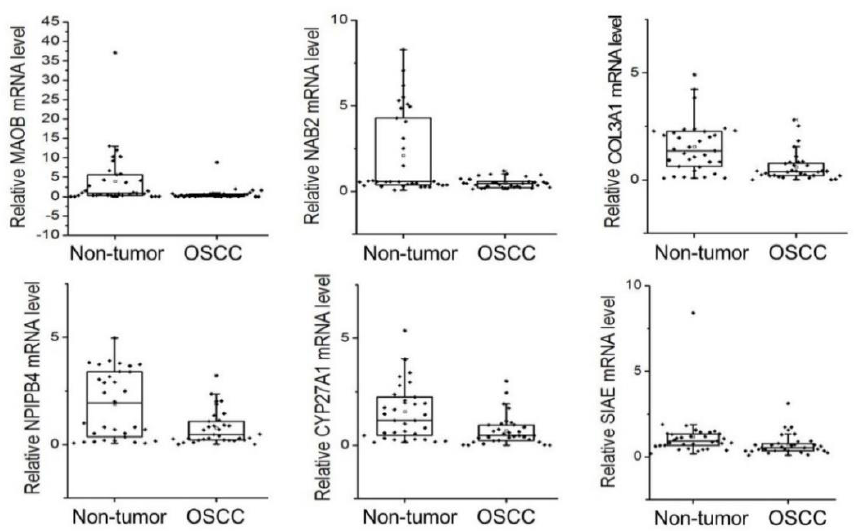
Figure 1. Comparison of salivary mRNAs between control and oral squamous cell carcinoma (OSCC) patients with the relative level (fold change) of the six candidate genes by qPCR analysis. Boxes extend from the third quartile to first quartile, with the line at the median. OSCC: oral squamous cell carcinoma. Table 2. Average mRNA levels of six candidate genes in non-tumor controls and oral squamous cell carcinoma (OSCC) groups.